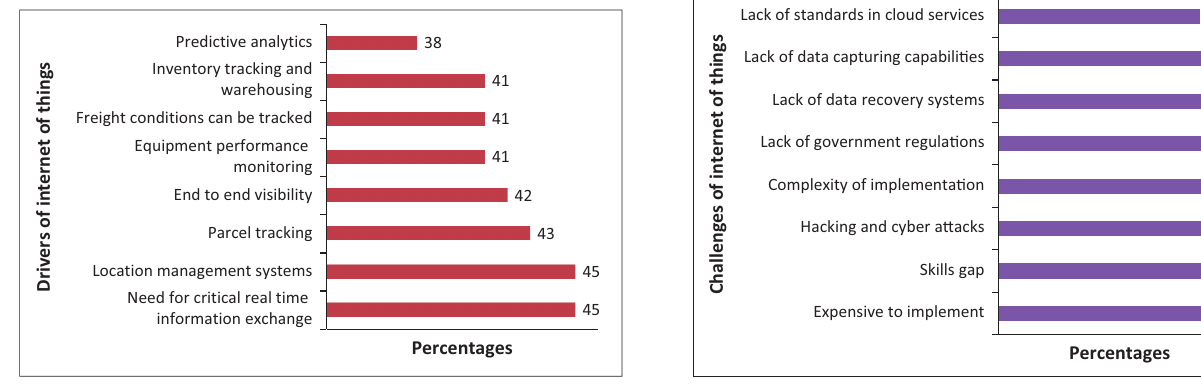
FIGURE 5: Challenges of implementing internet of